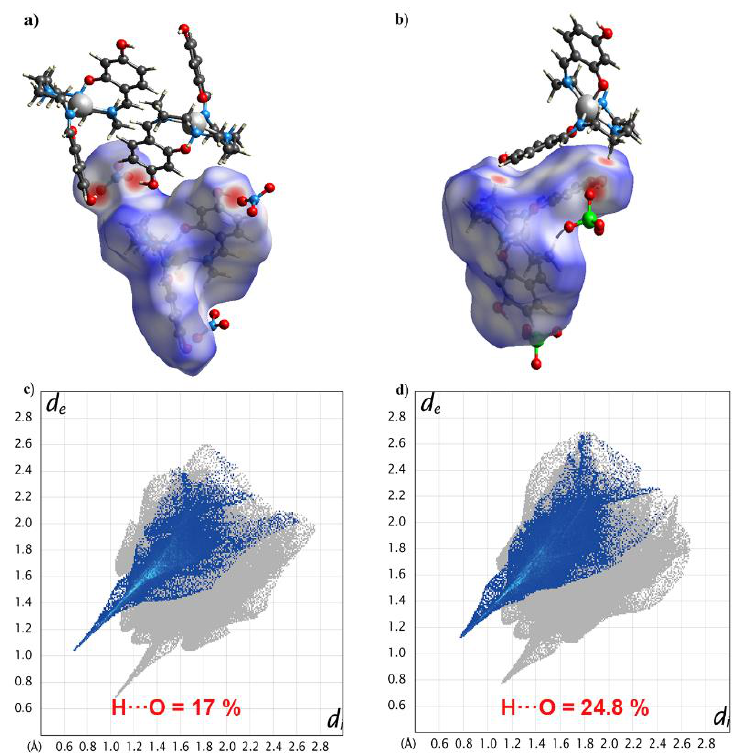
Figure 6. The N – H···O and O – H···O hydrogen bonding interactions in 1 ( a ) and 2 ( b ) through Hirshfeld surface mapping by d norm function. 2D fingerprint plots of all contacts: H···O for 1 ( c ) and 2 ( d ) at 298 K.